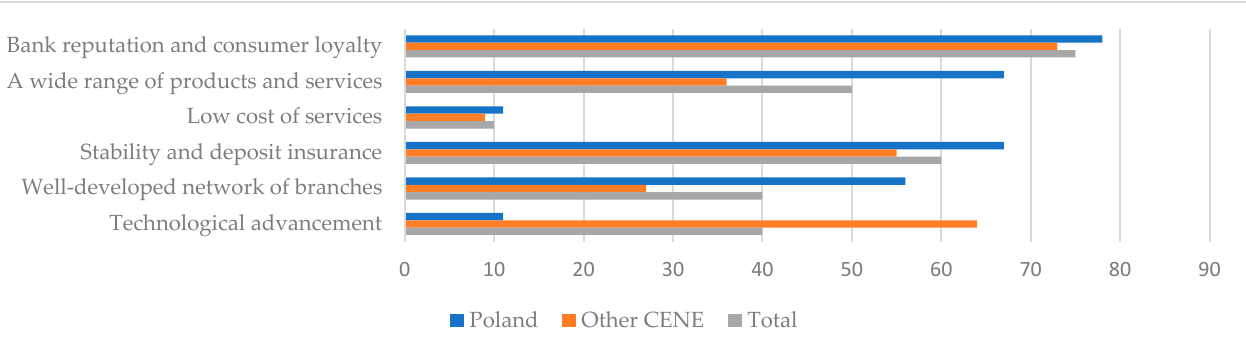
Figure 7. What are the competitive advantages of banks in relation to the Fintech sector? (up to 3 answers).